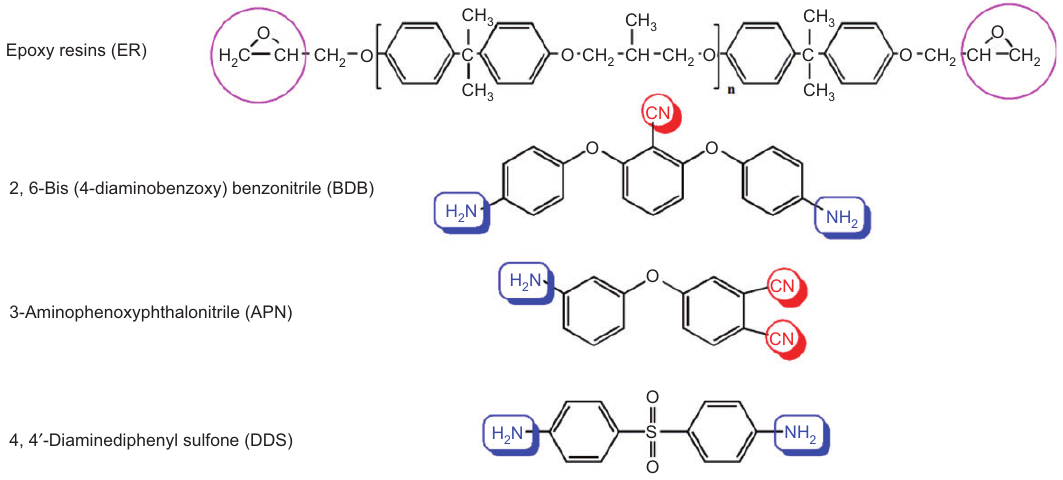
Figure 1 The structures of the amines and epoxy resin.